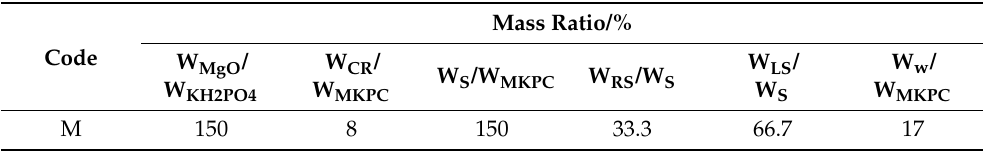
Table 3. Mix ratio of magnesium potassium phosphate cement (MKPC)